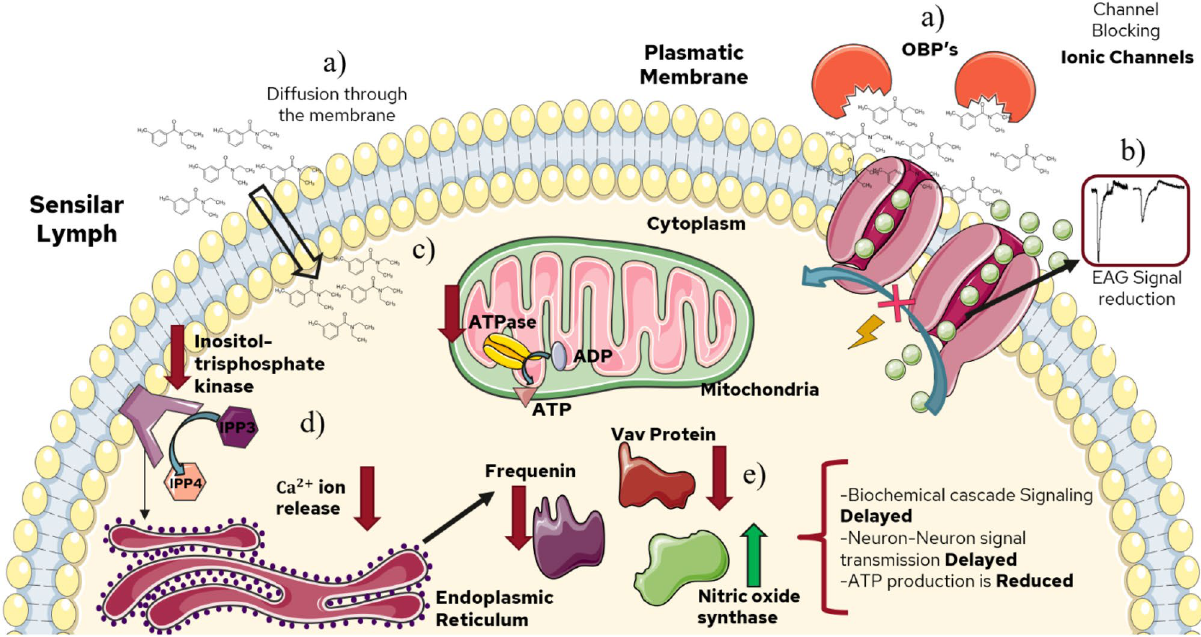
Figure 9. Possible action/reception mechanism for DEET repellent treatment. ( a ) The volatile molecules are transported to the ionic channels by odorant-binding proteins (OBP’s) or are diffused into the cell membrane. ( b ) The interaction DEET-ionic channel decreases the ionic channel activity, thus, reducing the electrical signal. ( c ) DEET repellent inhibits the ATPase protein expression, important to produce ATP in the mitochondria. ( d ) The entry of DEET into the olfactory system alters the protein expression needed to release Ca 2+ ions, therefore, inhibiting the proper functioning of other related processes. ( e ) Other downregulated and over-expressed proteins trigger delays in signaling cascades and chemical signaling